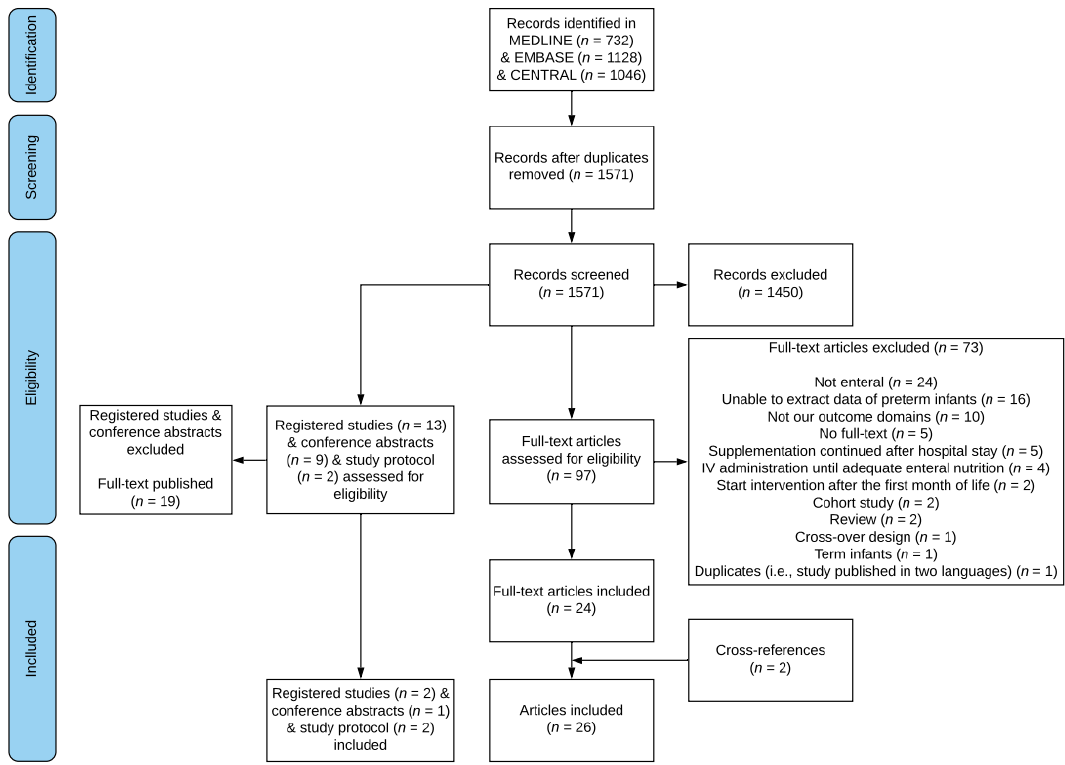
Figure 1. Flowchart of the study selection process.